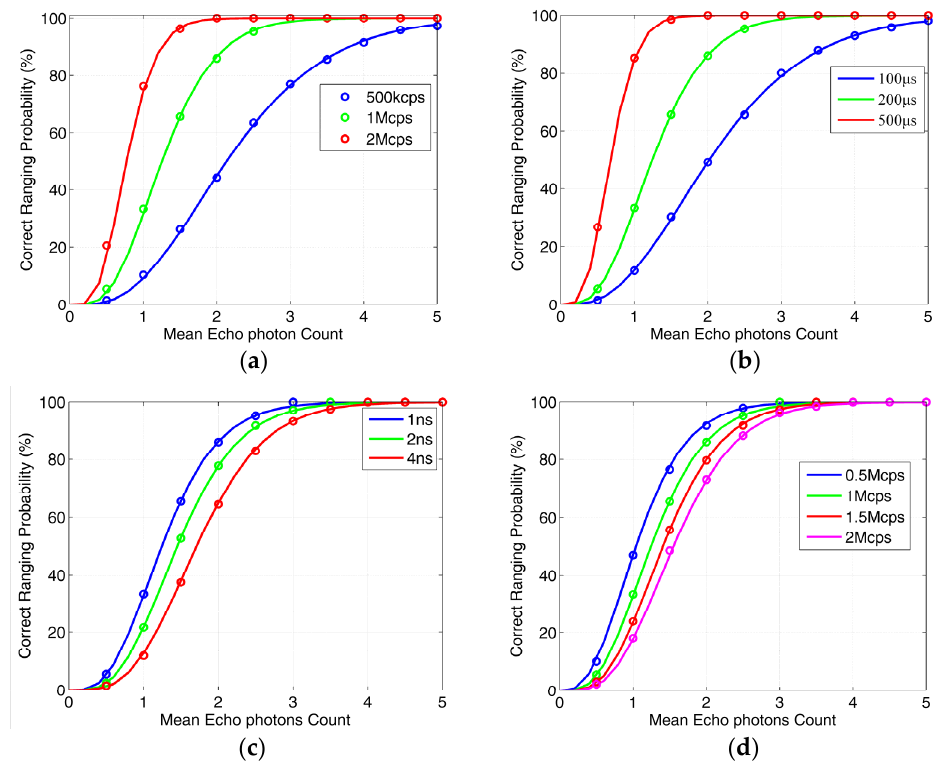
Figure 6. Monte Carlo simulation verification of correct ranging probability: ( a ) the influence of mean echo photon number and mean pulse count density on correct ranging probability (sequence length 200 µ s, pulse width 1ns, mean noise count density 1 Mcps); ( b ) the influence of sequence length on correct ranging probability (pulse count 1 Mcps, noise count density 1 Mcps, pulse width 1 ns); ( c ) the influence of pulse width on correct ranging probability (sequence length 200 µ s, mean pulse count 1 Mcps); ( d ) the effect of noise count density on detection probability (sequence length 200 µ s, mean pulse count density 1 Mcps, pulse width 1 ns).